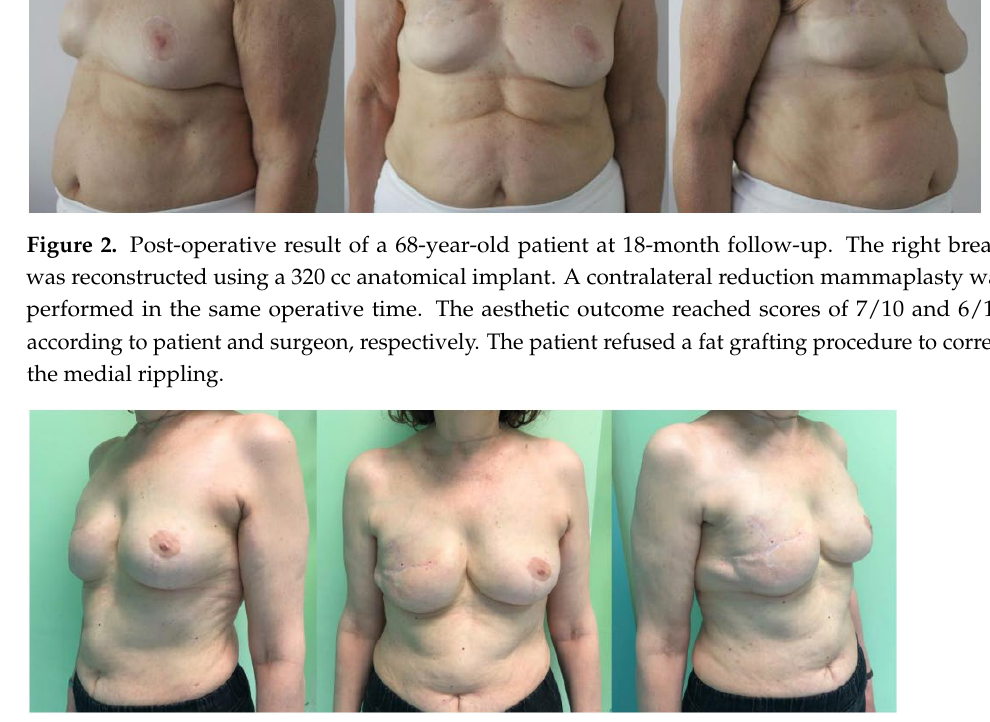
Figure 3. Post-operative pictures of a 62-year-old patient at 15-month follow-up. A 285 cc anatomical breast implant was used to reconstruct the right breast. In the early post-operative period, the patient presented a superficial necrosis of the upper and lower mastectomy flap, which was treated conservatively. The patient was highly satisfied with the aesthetic result (VAS 9 out of 10). Complications Evaluation of early and late complications was performed in all patients. Four pa- tients (22%) suffered from wound dehiscence and were managed conservatively. In three patients (17%), superficial mastectomy flap necrosis required debridement and primary closure in day surgery. No implant exposure occurred in this series. Among late compli- cations, capsular contracture was seen in seven patients (four Baker stage II and three Baker stage III, total 39%); however, no patient was willing to undergo implant exchange. In three patients (23%) a secondary lipofilling procedure was performed to enhance the aesthetic outcome and the skin tissue quality. Complications are listed in Table 3. Table 3. Complications after direct-to-implant reconstruction. Variable Total Patients (n = 18)